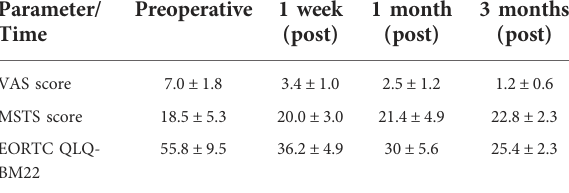
TABLE 2 Pain, function and QoL